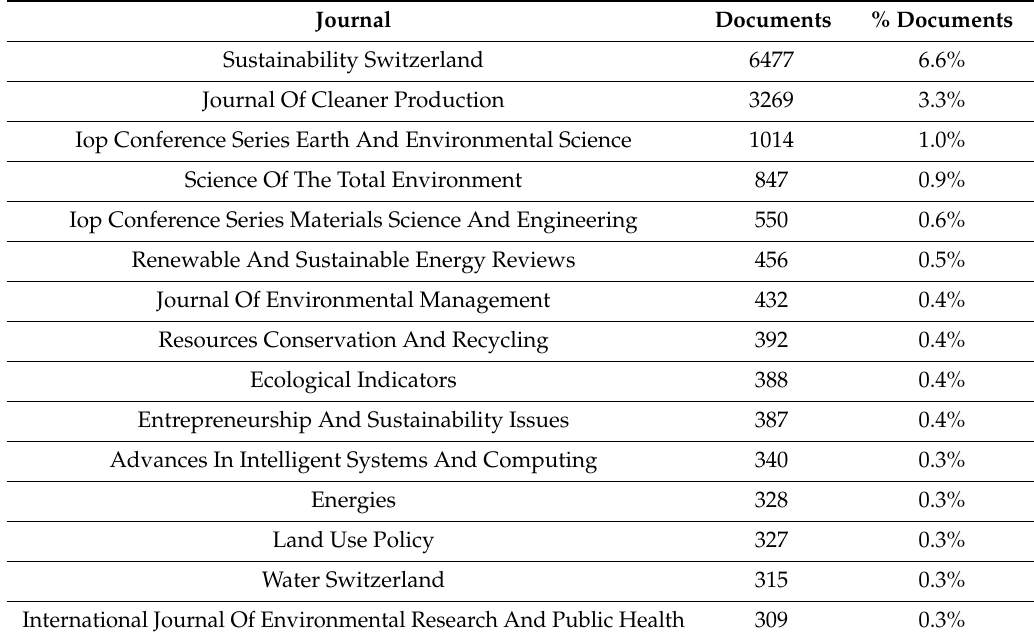
Table 5. Journals on sustainability between 2016 and